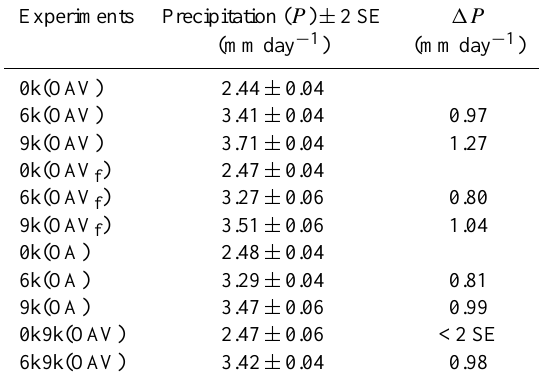
Table 2. Mean summer (JJAS) precipitation over the region 10– 25 ◦ N, 20 ◦ W–30 ◦ E in the various experiments. (cid:49)P denotes anomalies relative to the corresponding 0k (PI) case. SE is the stan- dard error. Precipitation values are normally distributed according to a Shapiro–Wilk normality test (95% confidence level).